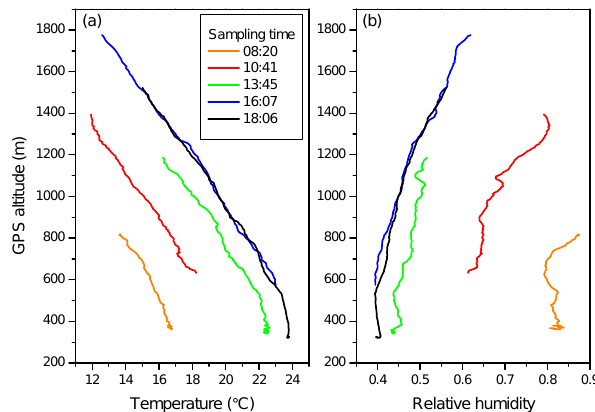
Fig. 11. The vertical profiles of (a) isoprene and (b) MVK+MACR on 10 August 2012. The sampling times indicate the beginning of each flight in local time. Altitude is given in meters above mean sea level; elevation of Columbia is 200m MSL.